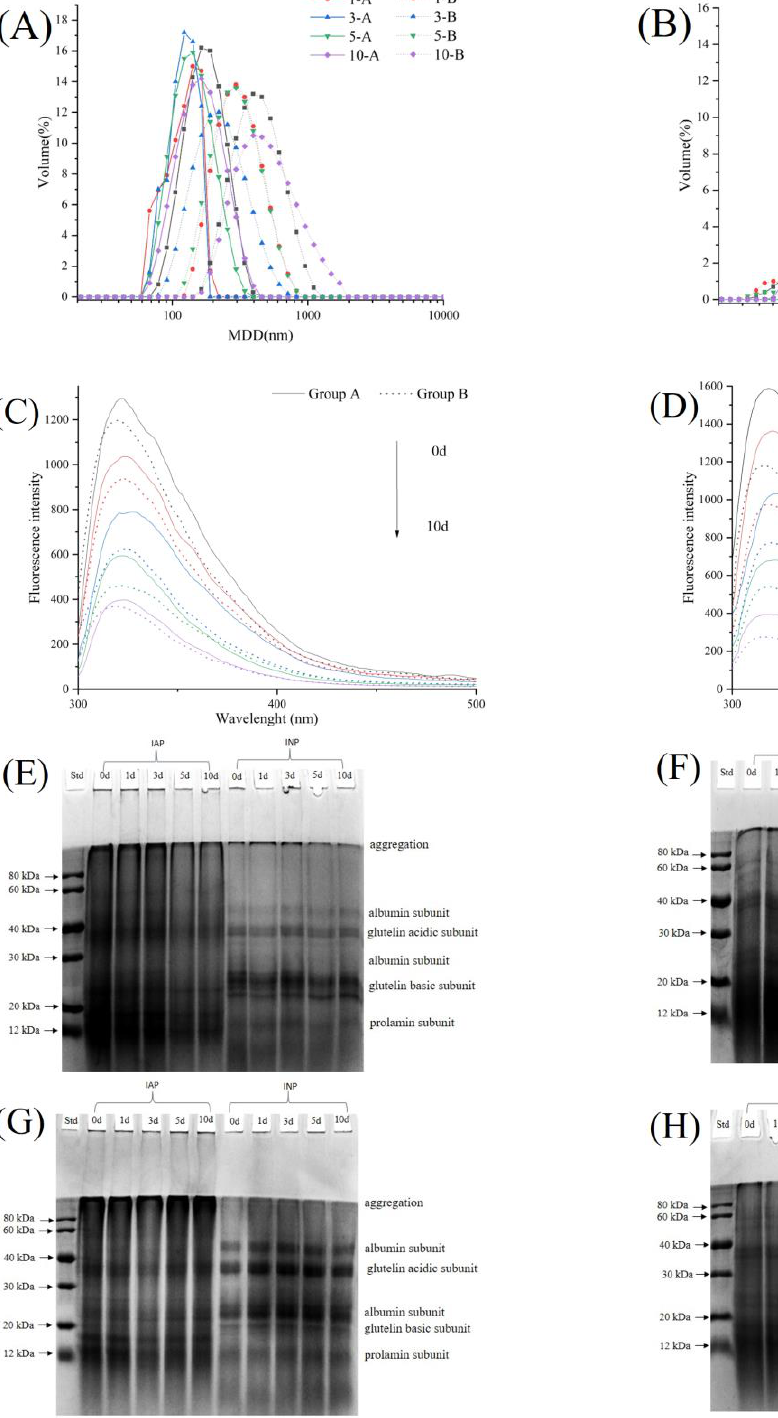
Figure 4. Effects of ultrasonic intensity on particle size distribution (( A ): particle size distribution of IAP; ( B ): particle size distribution of INP), intrinsic fluorescence spectra (( C ): intrinsic fluorescence spectrum of IAP; ( D ): intrinsic fluorescence spectrum of INP) and the aggregation morphology (( E ): non-reductive SDS-PAGE of IAP and INP in group A; ( F ): reductive SDS-PAGE of IAP and INP in group A; ( G ): non-reductive SDS-PAGE of IAP and INP in group B; ( H ): reductive SDS-PAGE of IAP and INP in group B) of IAP and INP of RBPE prepared with RB with different storage times. Analysis of the SDS-PAGE of IAP and INP of RBPE Prepared from RBP with Different